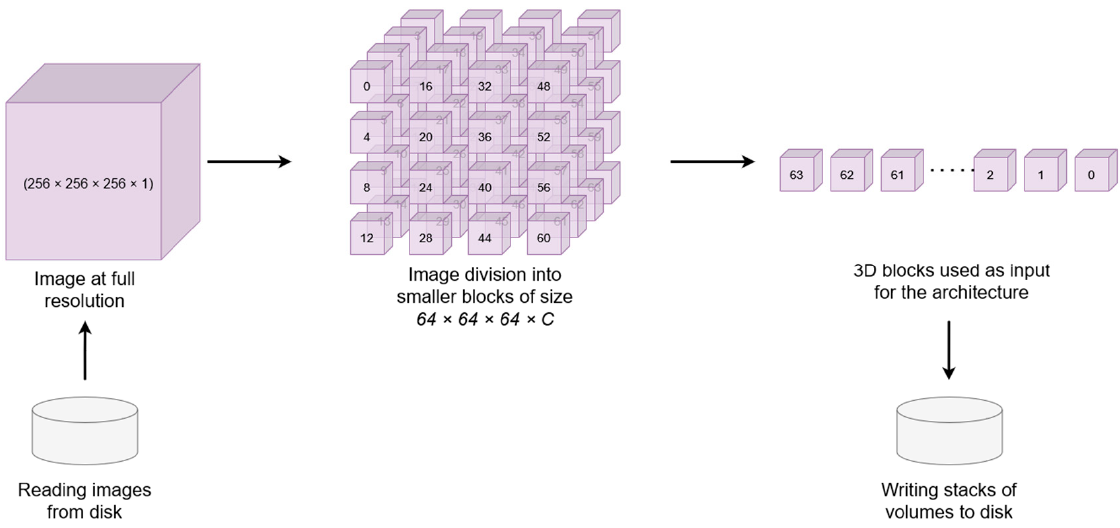
Figure 1. MRI volume divided into nonoverlapping subvolumes of size 64 × 64 × 64 voxels.